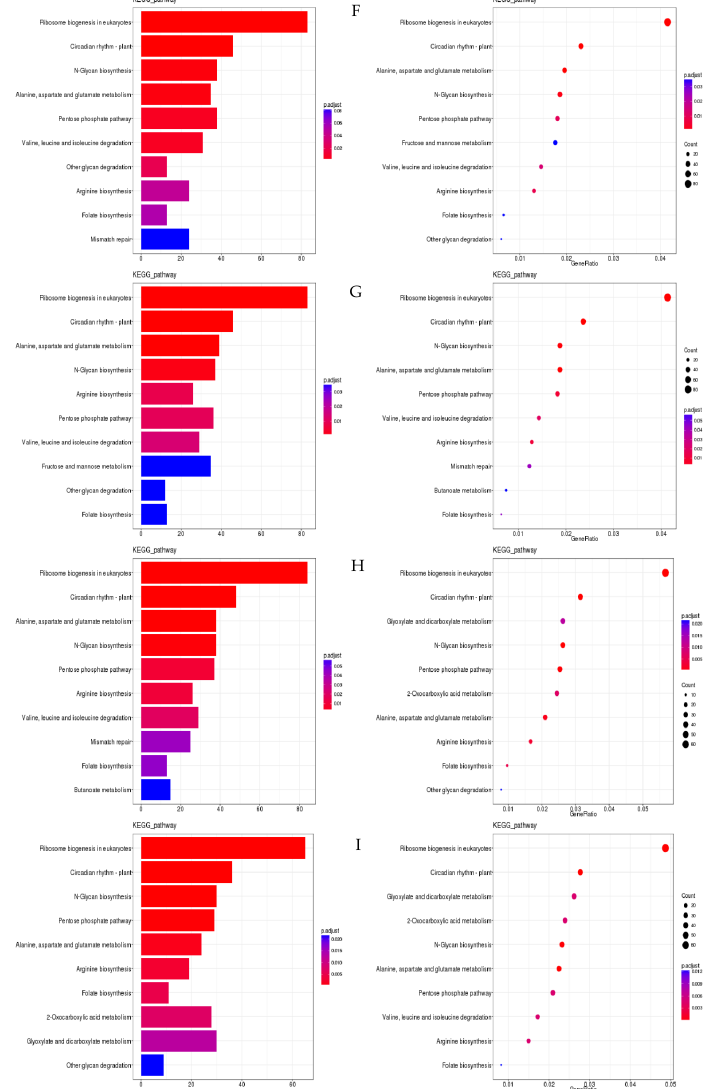
Figure 10. Bar chart and bubble chart of KEGG enrichment. Note: KEGG enrichment bar graph: the abscissa is GeneNum, which is the number of genes of interest annotated in the entry, and the ordinate is each pathway entry. The colour of the column represents the p -value of the hyper- geometric test. KEGG enrichment bubble chart: the abscissa is GeneRatio, which is the ratio of the gene of interest annotated in this entry to the number of differentially expressed genes, and the ordinate is each pathway entry. The size of the dot represents the number of differentially expressed genes annotated in the pathway, and the colour of the dot represents the p -value of the hypergeometric test. ( A ) XJ0hR1_XJ0hR2_XJ0hR3_vs_XJ0hS1_XJ0hS2_XJ0hS3; ( B ) XJ0hR1_ XJ0hR2_ XJ0hR3_vs_XJ12hR1_XJ12hR2_XJ12hR3; ( C )